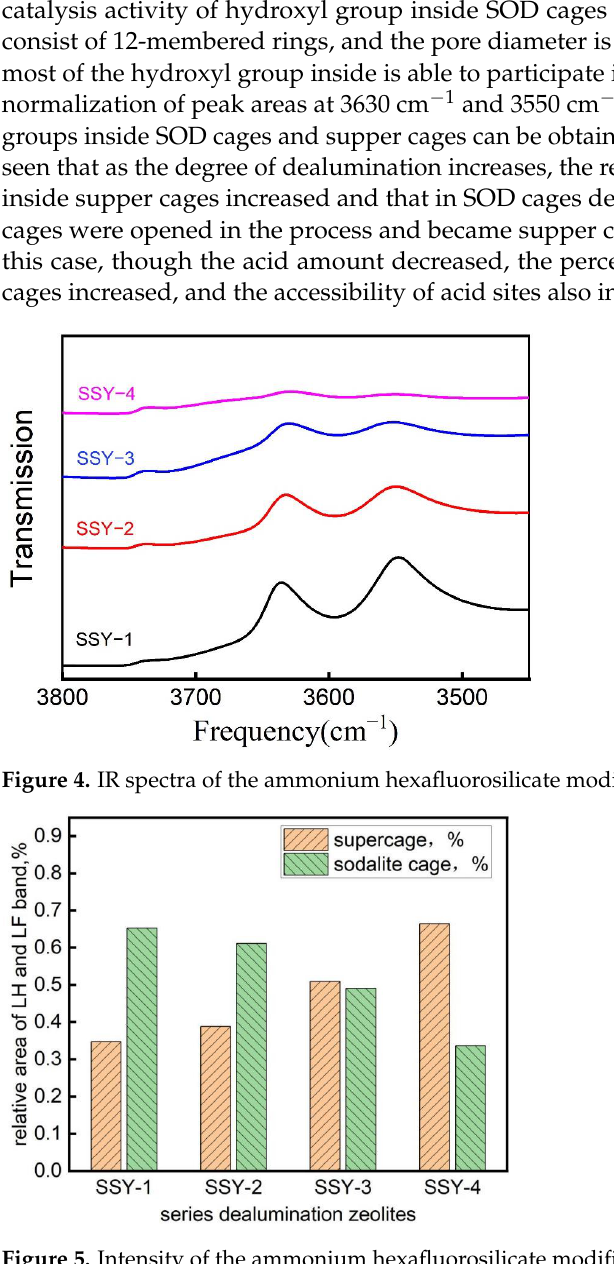
Figure 5. Intensity of the ammonium hexafluorosilicate modified zeolites HF and LF bands. HF: the high frequency band at 3630 cm − 1 . LF: the low frequency band at 3550 cm − 1 .